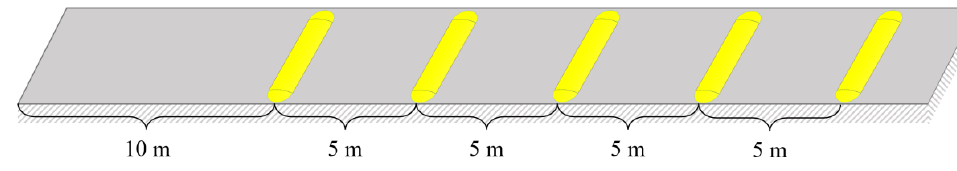
Figure 7. Straight road with speed bumps.